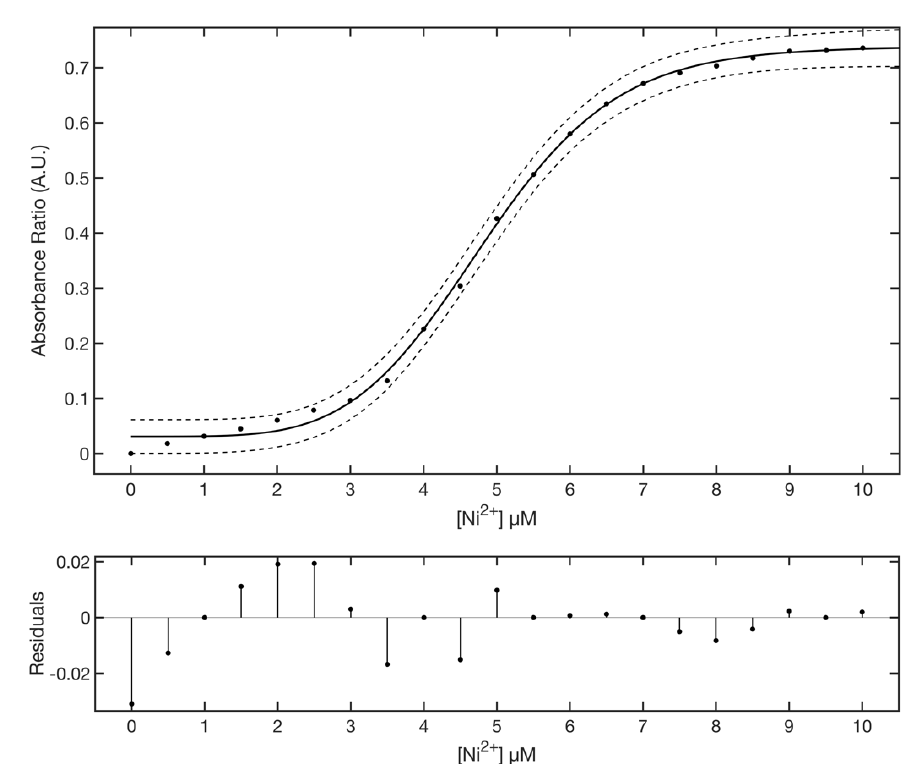
Figure 8. Upper panel: dependence of absorbance ratio from Ni 2+ concentration. Fit of raw data for Ni-AgNPs@11MUA to Equation (1) (solid line). The 95% confidence interval is shown (dashed line). Lower panel: residuals plot of the fitting.